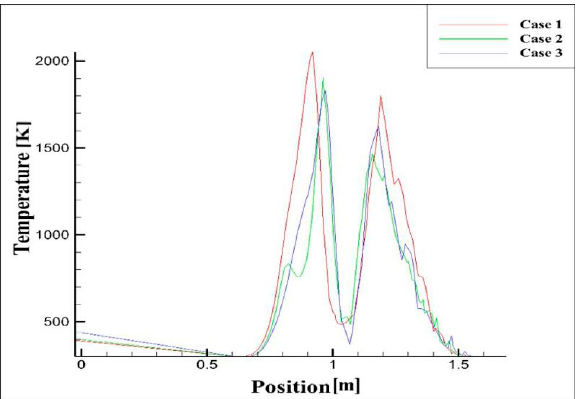
Figure 5. A validation for 3 different mesh element numbers with temperature variation along the incinerator